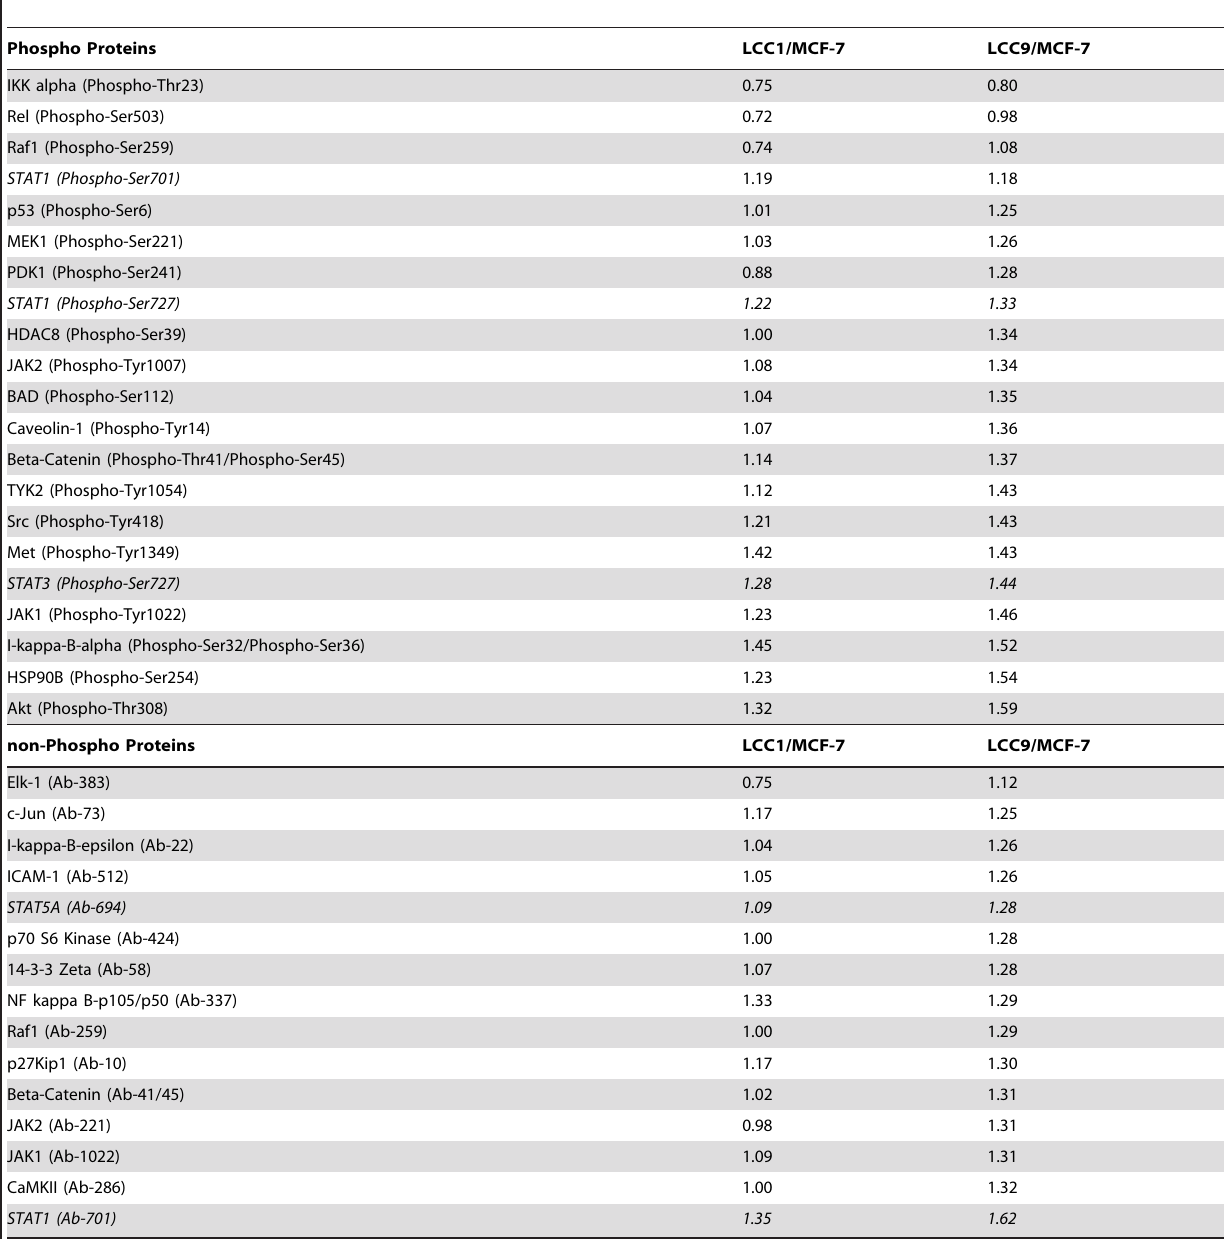
Table 1. List of proteins and phospho-proteins significantly differentially expressed between LCC1 or LCC9 and parental MCF-7 cell